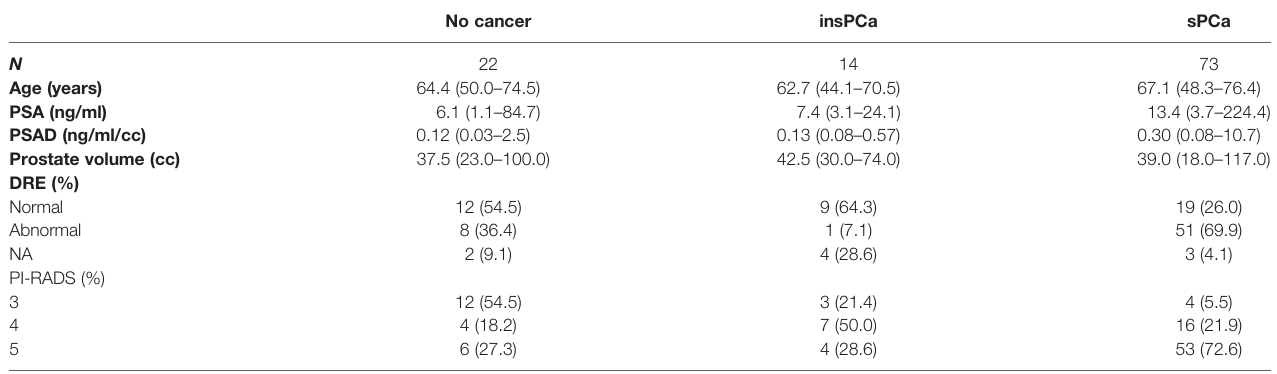
TABLE 3 | Clinical characteristics of men with positive multiparametric prostate MRI (PI-RADS 3 – 5).